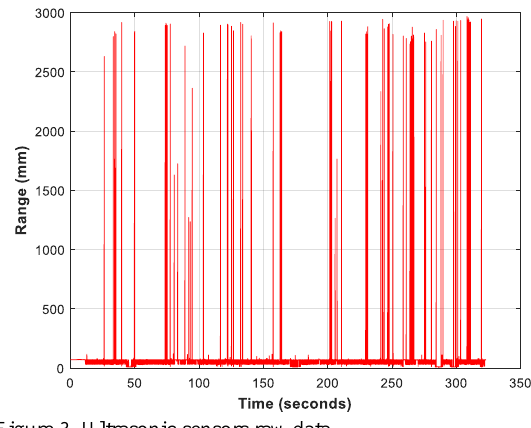
Figure 3. Ultrasonic sensors raw data